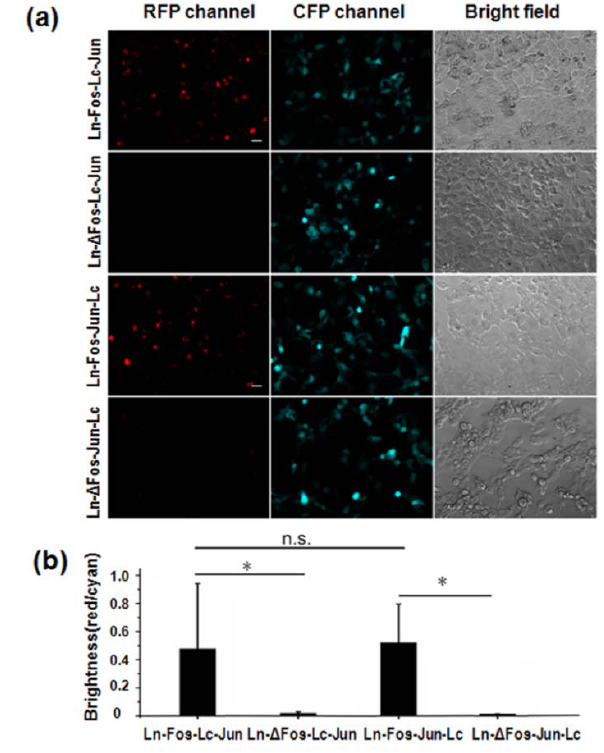
Figure 1. BiFC efficiency of the mLumin-based BiFC system with a bicistronic expression vector. ( a ) Fluorescence imaging and ( b ) BiFC efficiency analysis of COS-7